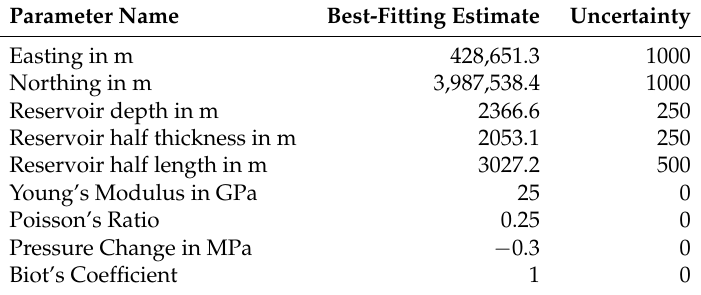
Table 1. Finite element modeling results from Ali et al.